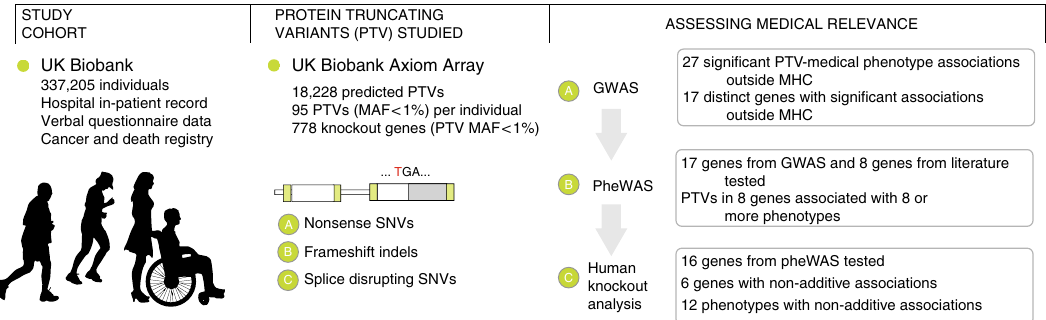
Fig. 1 Schematic overview of the study. We prepared a data set of 18,228 protein-truncating variants and 135 medical phenotypes from the UK Biobank data set of 337,205 individuals. From these data, we analyzed the clinical effects of predicted protein-truncating genetic